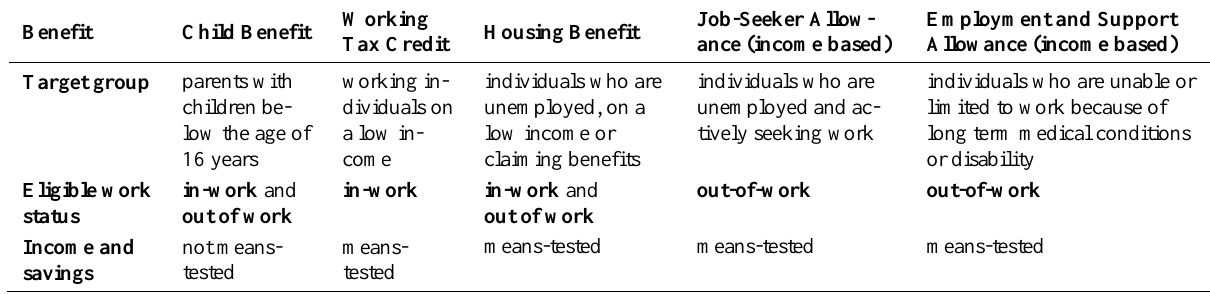
Table 1. Selected social benefits in the UK